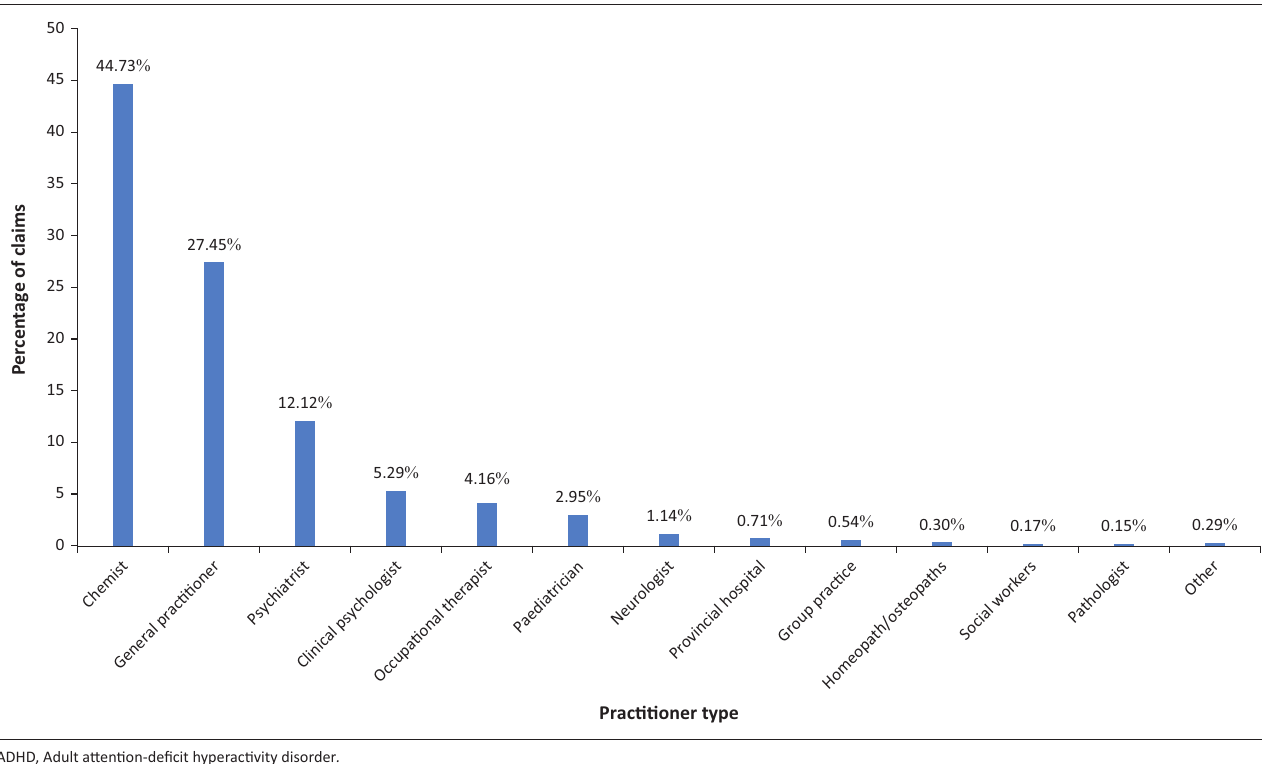
FIGURE 1: Percentage of claims linked to ADHD diagnostic codes.